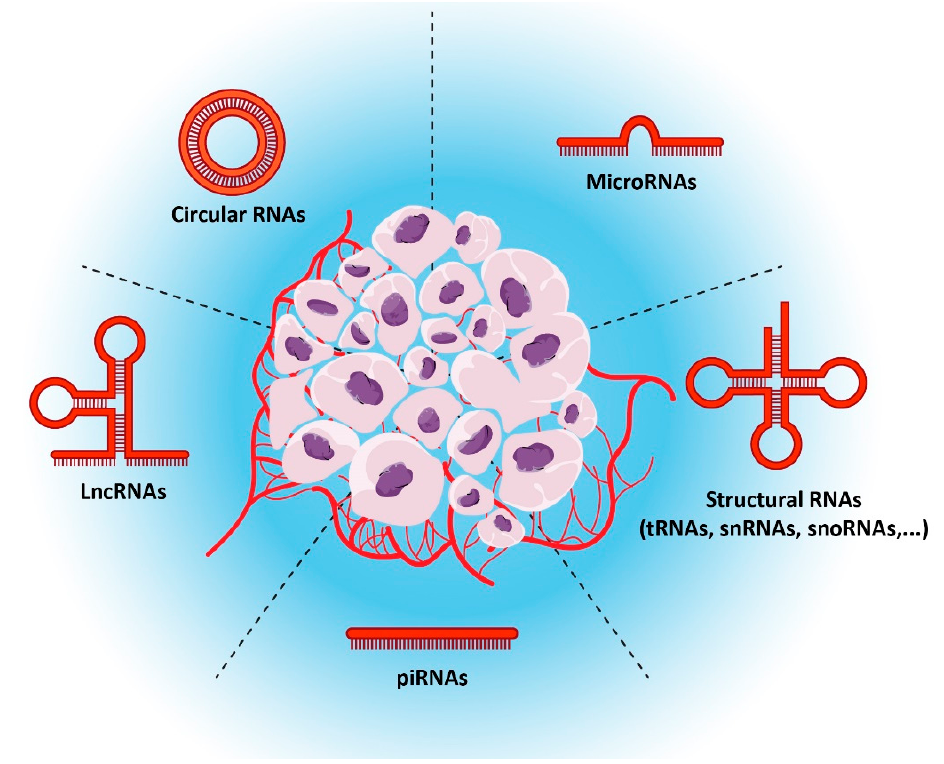
Figure 1. Different types of non-coding RNA.